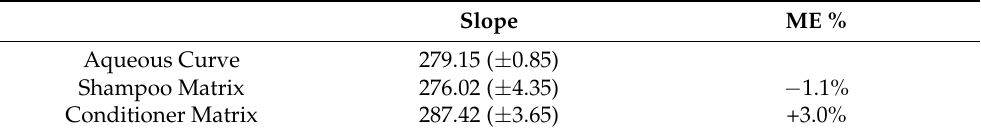
Table 2. Evaluation of the matrix effect (ME %) in shampoo and conditioner